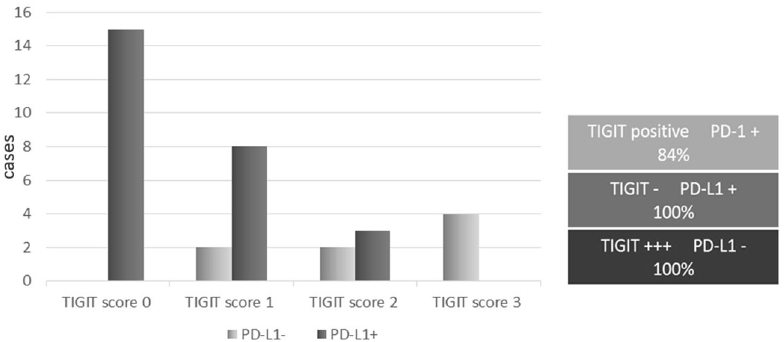
Figure 2. Left side: histogram shows the relationship between TIGIT and PD-L1 expression. PD-L1 expression decreases while TIGIT score increases. TIGIT negativity is always associated with PD-L1 positive reaction on HRS cells. The higher TIGIT expression is always associated with PD-L1 negativity on HRS cells. Right side: the scheme summarizes this result and underlines the close relationship between TIGIT expression and PD-1 positivity on peritumoral